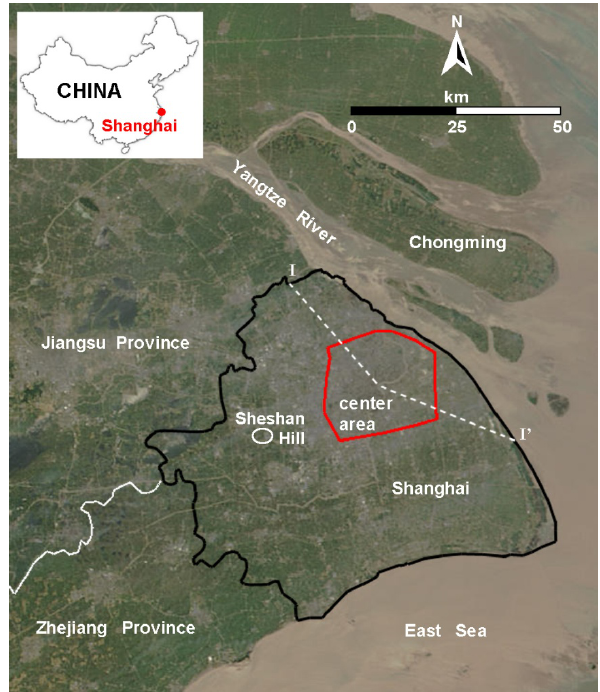
Figure 1. Location of the Shanghai City and the center area ad- dressed in the presentmodelling